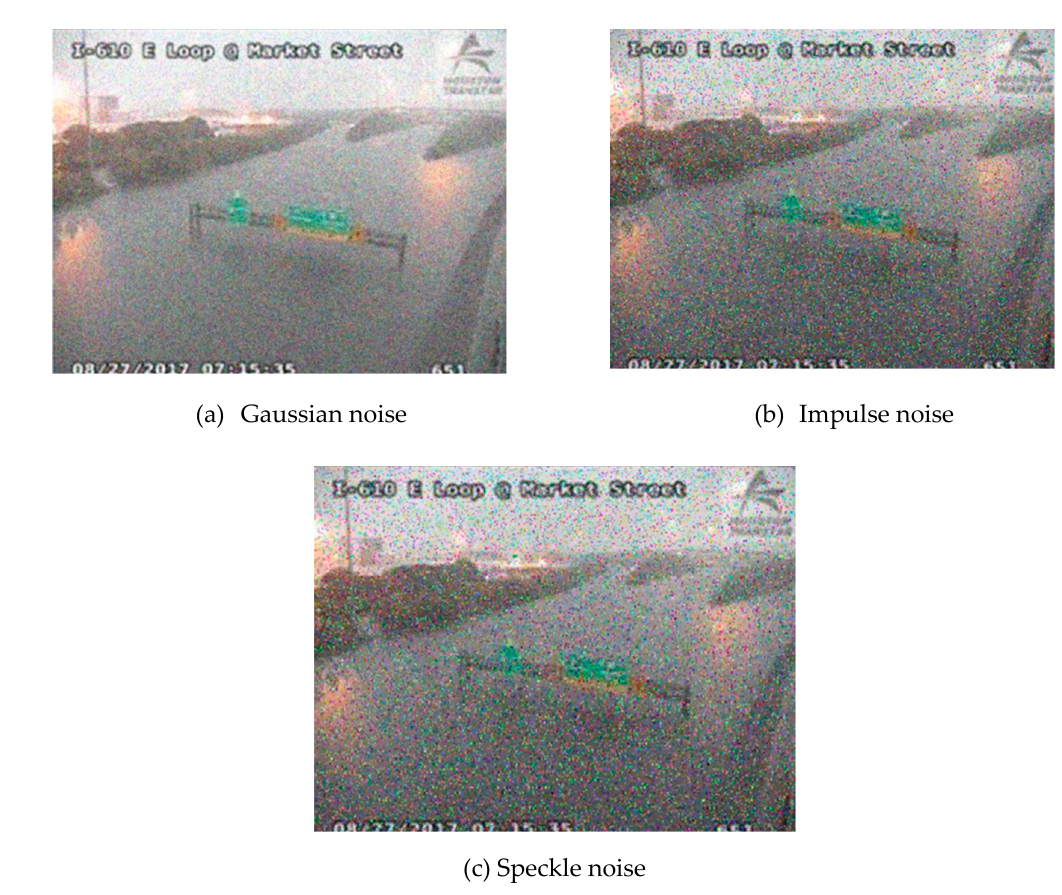
Figure 2. The example images with three different types of noises. ( a ) The Gaussian noise; ( b ) the impulse noise; and ( c ) the speckle noise.